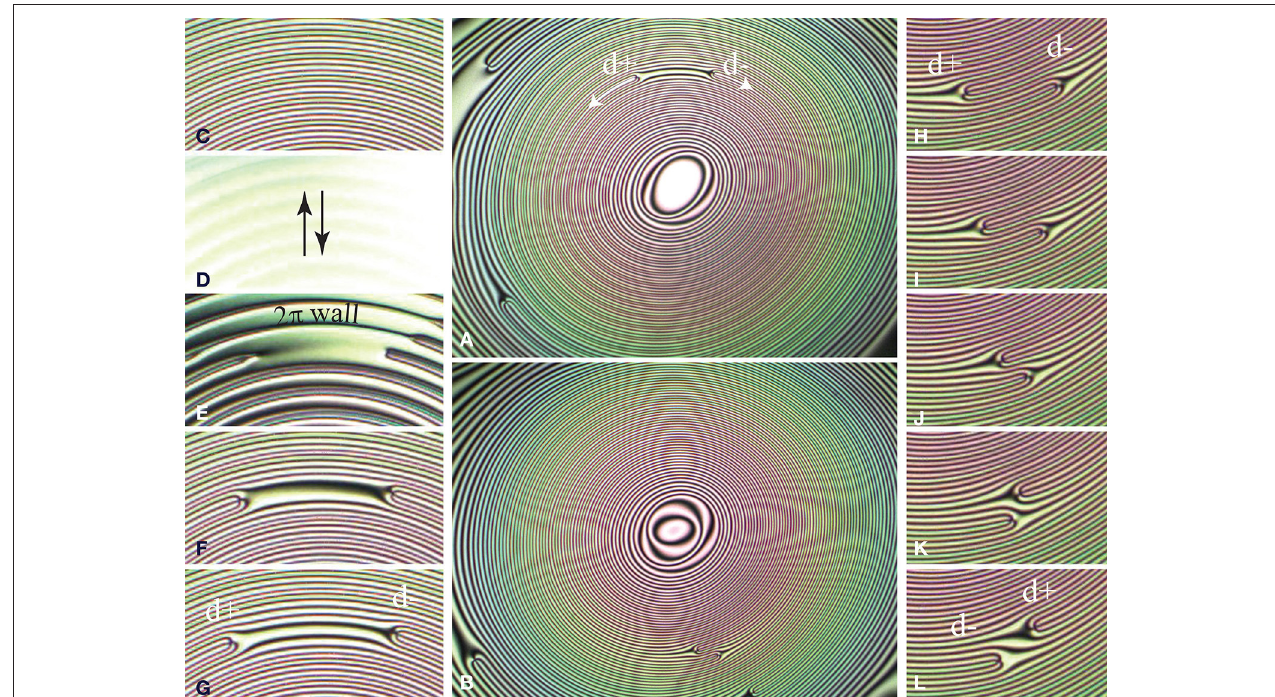
FIGURE 13 | Generation and collision of a dowsons’ pair in the Circular Dowsons Colider. (A) Wound up dowser field with a pair of dowsons “in statu nascendi.” (B) After a half turn of their orbits, the d + and d − dowsons are coming to a collision. (C–G) Generation of the dowsons pair. (H–L) Collision of the pair without annihilation.